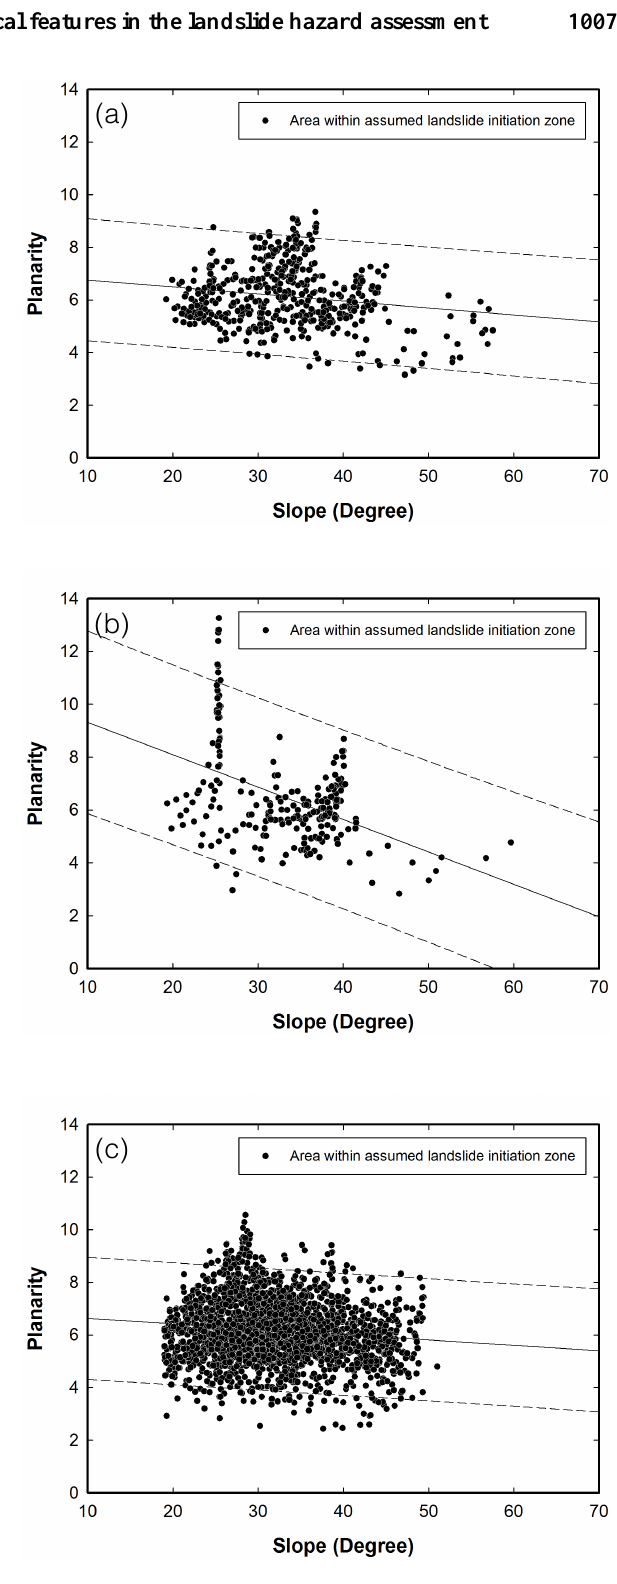
Figure 13. Relationships between planarity and slope in the study area. Values for slope and planarity are shown on the abscissa and ordinate, respectively. The linear regression is indicated by a black solid line and 95% of prediction intervals are also presented as black dotted lines. (a) Site A. (b) Site B. (c) Site